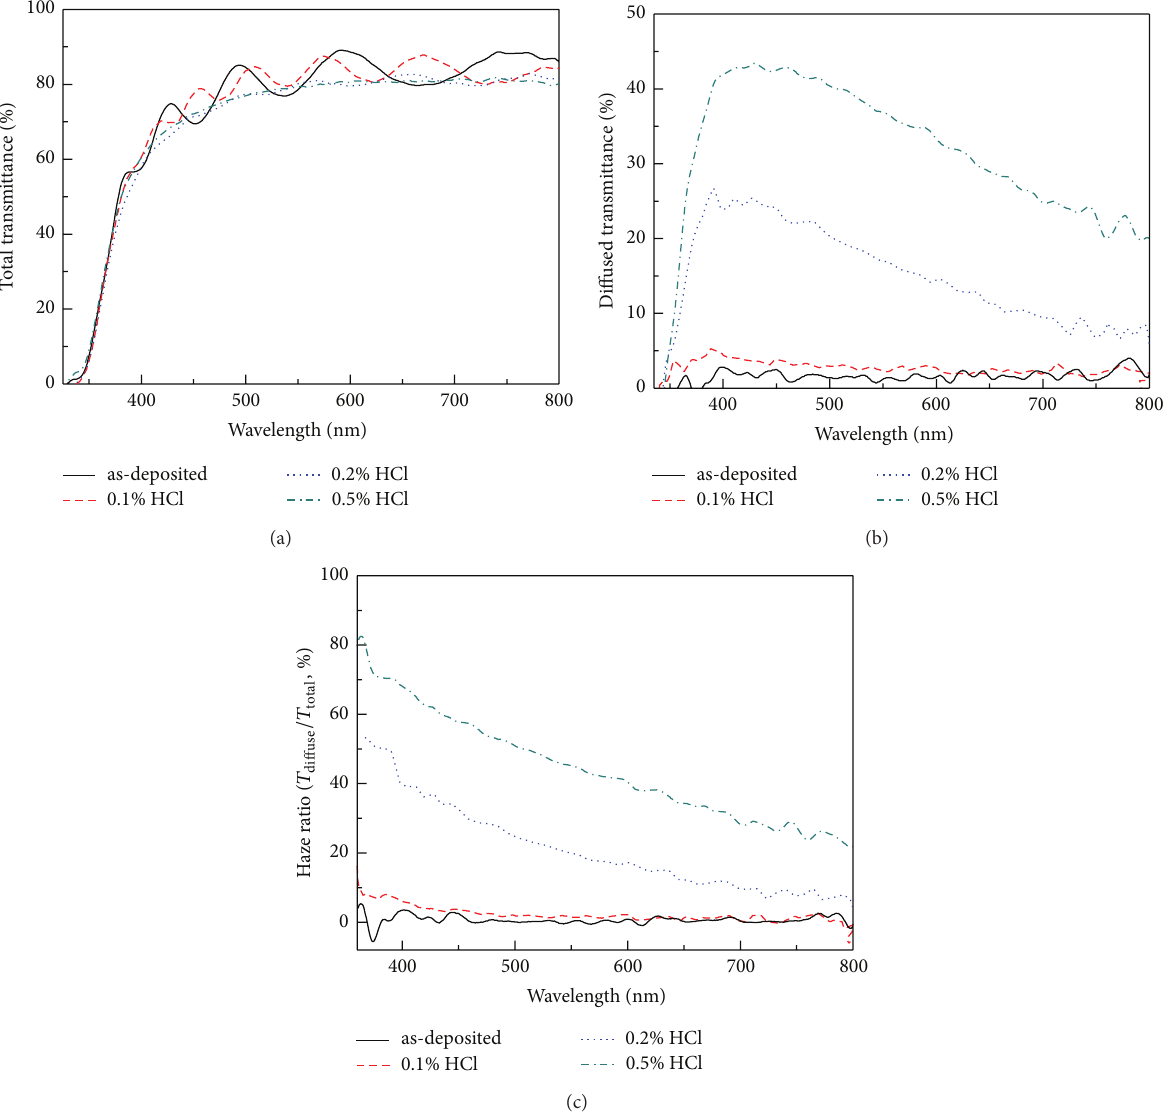
Figure 6: The optical characteristics: (a) total transmittance, (b) diffused transmittance, and (c) haze ratio of the HCl etched FZO substrates.